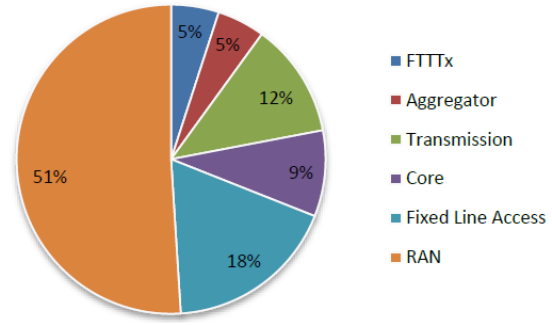
Figure 11. Distribution of power consumption across different network segments [78].